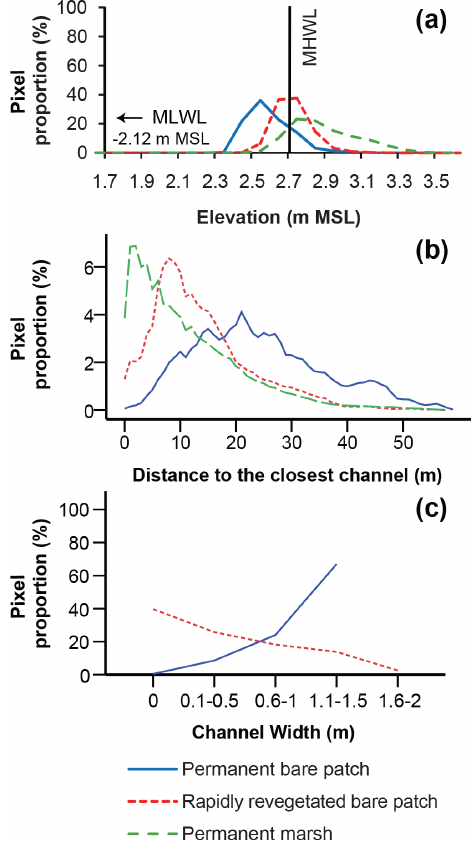
Figure 7. Frequency distribution of (a) elevation, (b) distances to the closest channel, and (c) the connected channel width for perma- nent bare patches, rapidly revegetated bare patches, and permanent marsh areas in Saeftinghe. The elevation is relative to mean sea level and binned into 0.1m intervals. The proportion in panel (a) is cal- culated as the number of pixels in each elevation class (every 0.1m) relative to the total number of pixels for each category. The pro- portion in panel (b) is calculated as the number of pixels in each distance class (every 1.0m) relative to the total number of pixels for each category. The proportion (%) in panel (c) is calculated as the number of pixels in each class of channel width relative to the total number of pixels that are permanently bare patches (blue line) or rapidly revegetated bare patches (dashed red